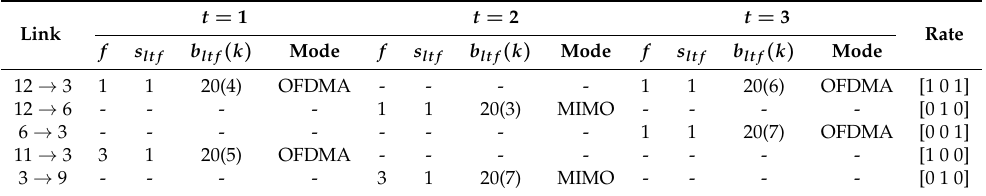
Figure 4. Resource allocation results for ( a ) the sum-rate maximization and ( b ) the max–min fair allocation. The max–min rate optimization achieves better fair resource allocation, at the expense of the sum-rate. Table 7. Resource Allocation Result for the Sum-rate Maximization.